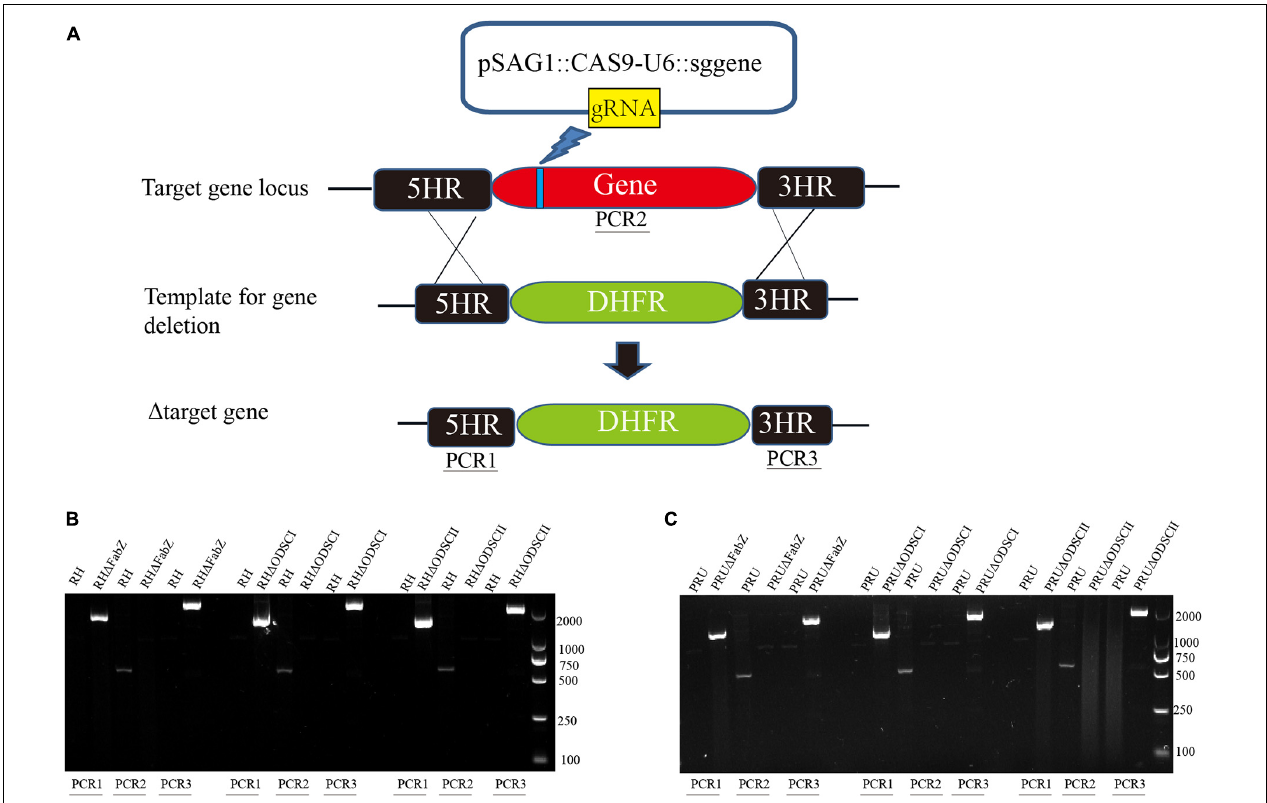
FIGURE 2 | Construction of gene knockout strain using CRISPR-Cas9 system. (A) Schematic diagram of the CRISPR-Cas9 strategy used to knockout the target genes FabZ , ODSCI , and ODSCII . (B,C) The knockout strains were verified by PCR analysis. The results showed that PCR1 and PCR3 amplified bands in knockout strains, while RH and PRU wild strains had no bands, indicating that DHFR fragments were successfully inserted into knockout strains from 5 (cid:48) to 3 (cid:48) ends by homologous recombination. PCR2 showed that bands were amplified in RH and PRU wild-type strains, while knockout strains had no bands, showing that genes were successfully